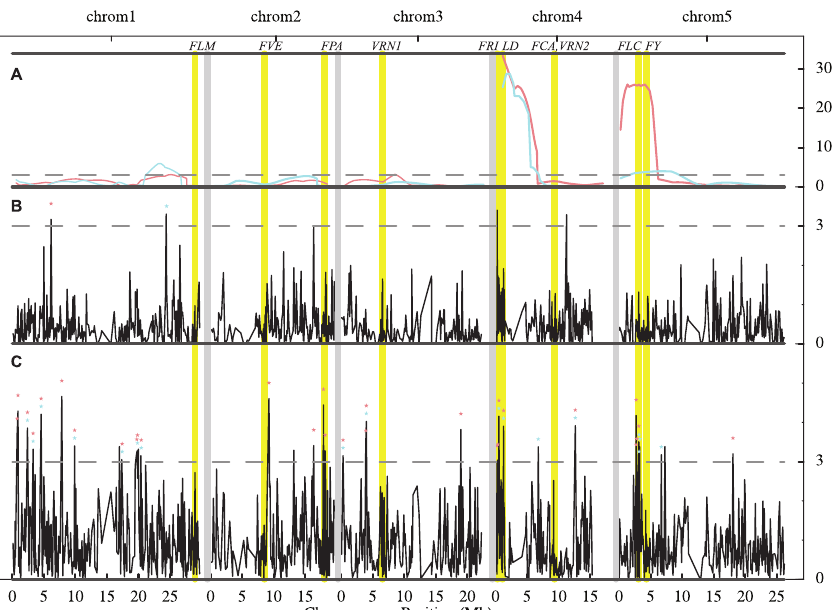
Figure 5. Comparison of Association and Linkage Mapping Results for the Phenotype JIC4W The position of candidate genes with higher marker density are highlighted in yellow. (A) The QTL LOD scores for two crosses: Col-0 3 Lov-1 (pink curve) and Col-0 3 Edi-0 (cyan curve). The dashed grey line marks a genome-wide permutation significance level of 5%. (B) Negative log p -values from a genome-wide scan using the Q þ K model. (C) Negative log p -values from a genome-wide scan using a naive Kruskal-Wallis approach. (B and C) The dashed grey line marks a nominal significance level of 0.1%, and the colored stars denote associations that should correspond to QTL in the cross displayed using the same color (because the appropriate alleles are segregating; see text).